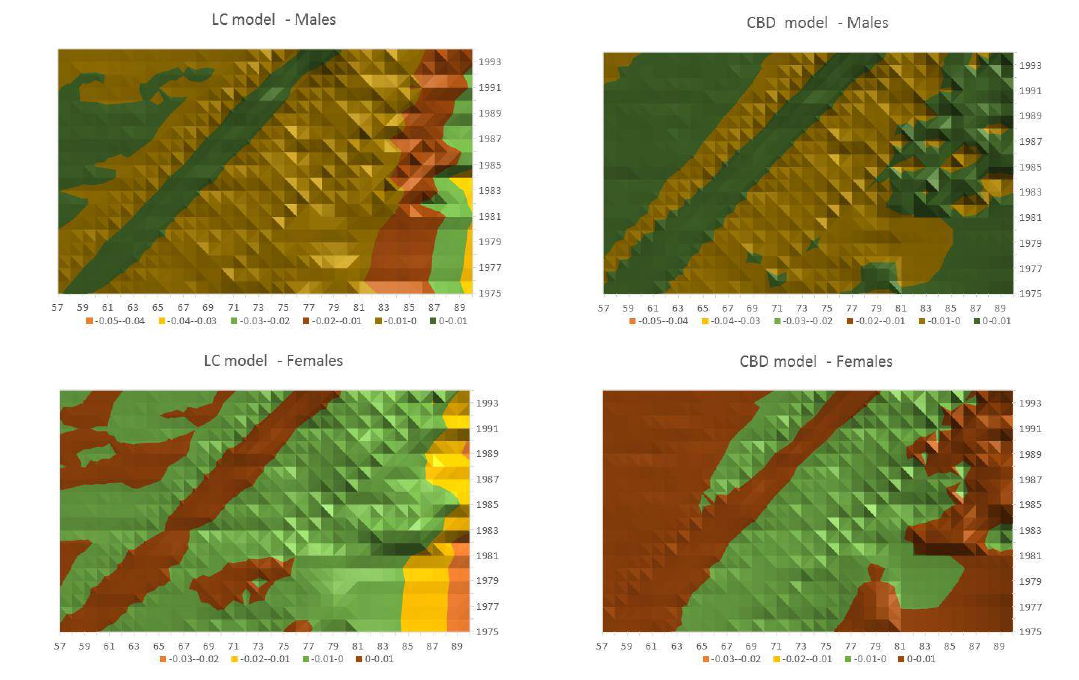
(cid:0) (cid:1) − q P q O by age x : x , t x , t